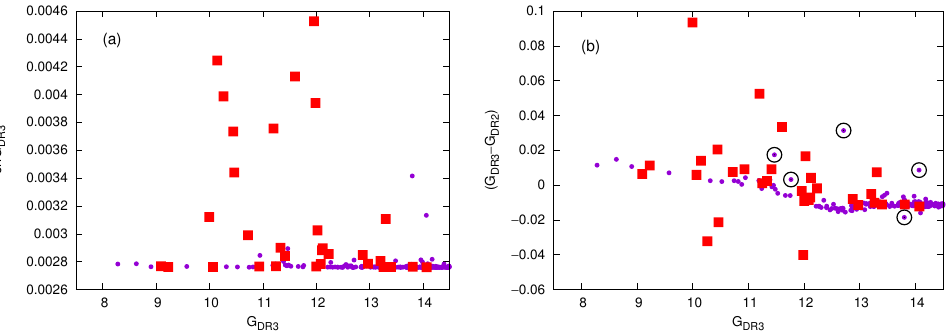
Figure 2. Data for the cluster NGC 663. ( a ) Error in the G DR 3 band versus G DR 3 magnitude. ( b ) (G DR 3 -G DR 2 ) versus G DR 3 . Violet small symbols indicate cluster members and red squares indicate known Be stars. The open black circles enclose objects that depart significantly from the tight relation for stable